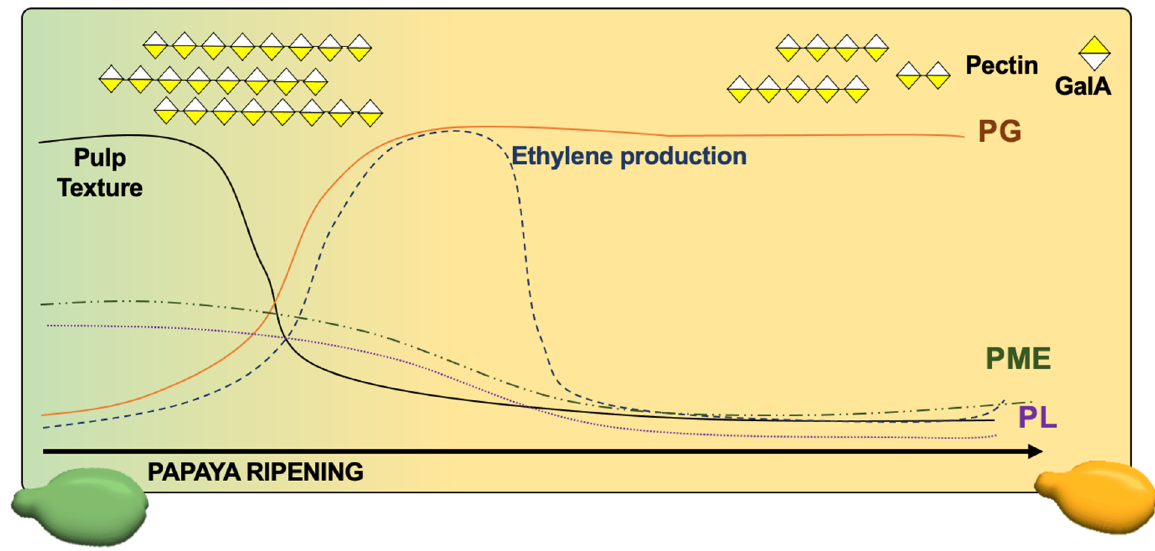
Figure 8. General representation of papaya fruit ripening and pulp softening. Papaya ripening is marked by a fast pulp softening due to a massive pectin mobilization driven by coordinated action of pectinases. While PMEs and PLs expressions decrease throughout ripening, PGs expression increases. GalA: galacturonic acid.